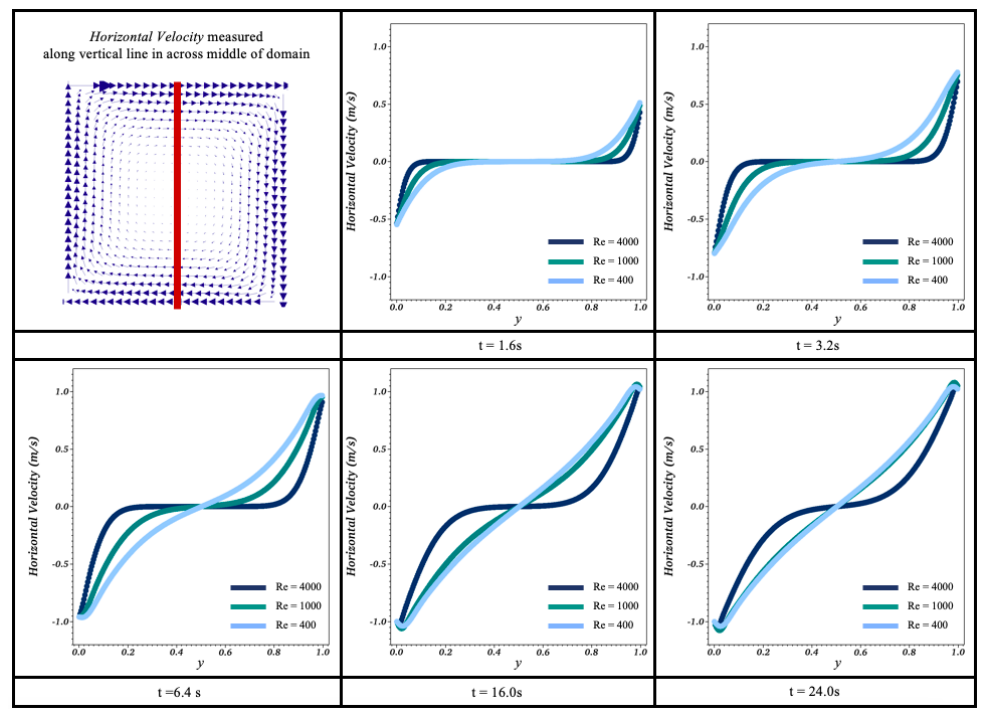
Figure 27. Snapshots showing horizontal velocity measurements across a vertical line centered in the domain among cases for Re = 400,1000, and